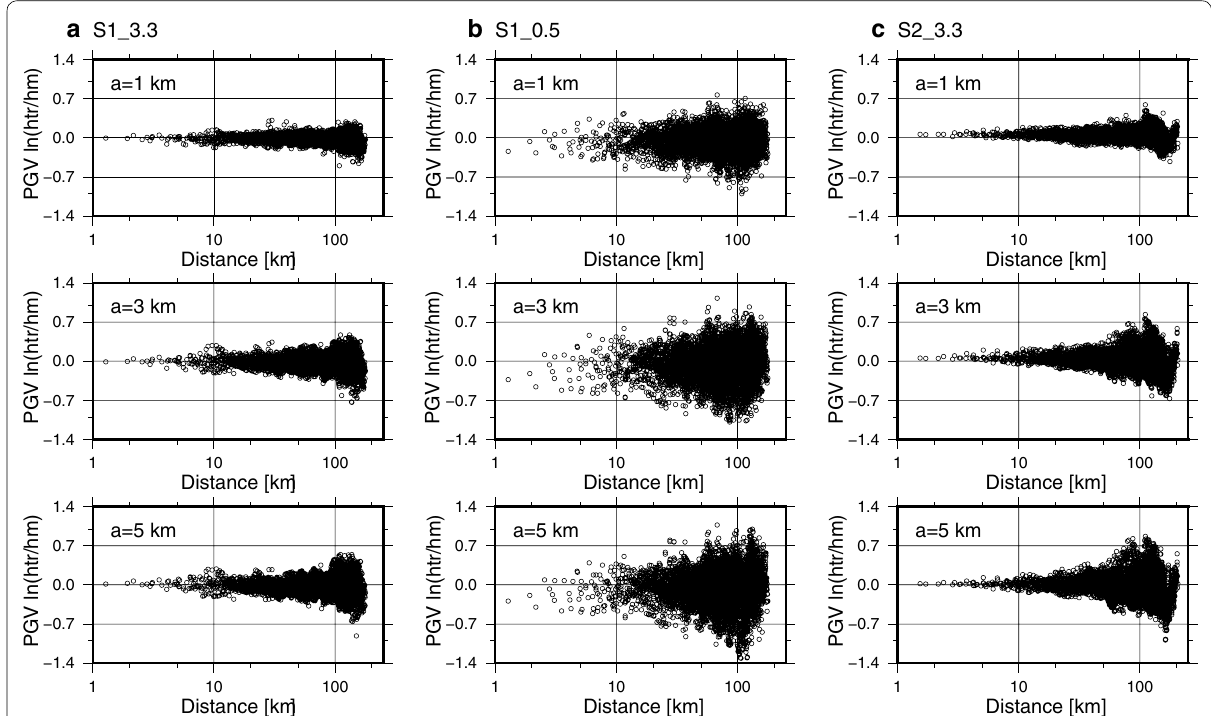
Fig. 8 Heterogeneous-to-homogeneous PGV ratio plotted against epicentral distance. PGV ratio is plotted at 2-km-interval grid points for heterogeneous velocity models with a 1, 3, and 5 km using source models a S1_3.3, b S1_0.5, and c =